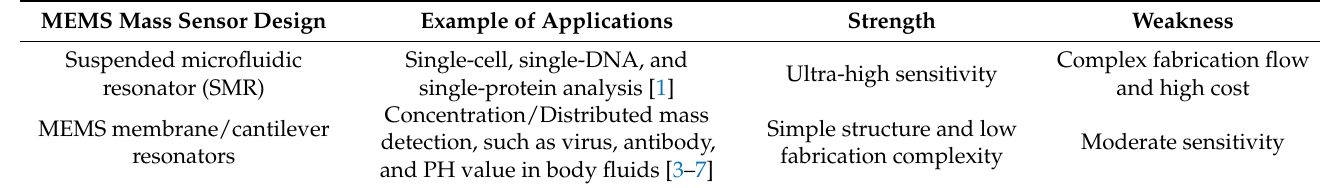
Table 1. Resonating MEMS mass sensors designs and corresponding applications.